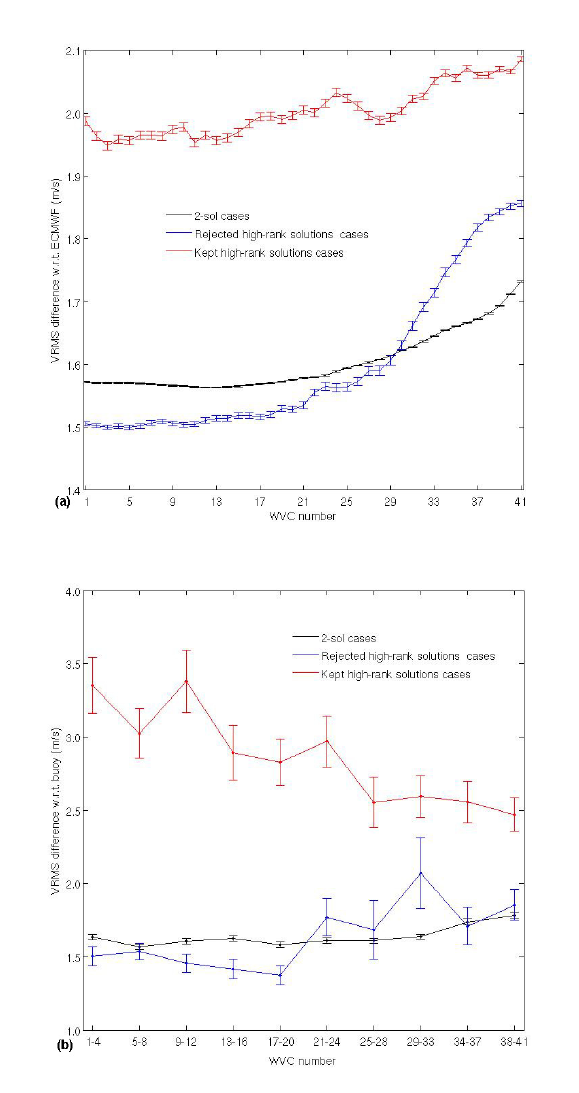
Fig. 5. The mean VRMS difference with respect to (a) ECMWF winds and (b) buoy winds as a function of WVC number, WVCs on both left and right swaths are numbered from 1 (outer-swath WVC) to 41 (near-swath WVC). Solid line indicates the result of two- solution cases; dashed line presents the result of cases with rejected high-rank solutions with threshold T = 40, and cross-marked line illustrates the result of cases with kept high-rank solutions. Marker “I” denotes the uncertainty bar of the estimated mean VRMS for each WVC bin.